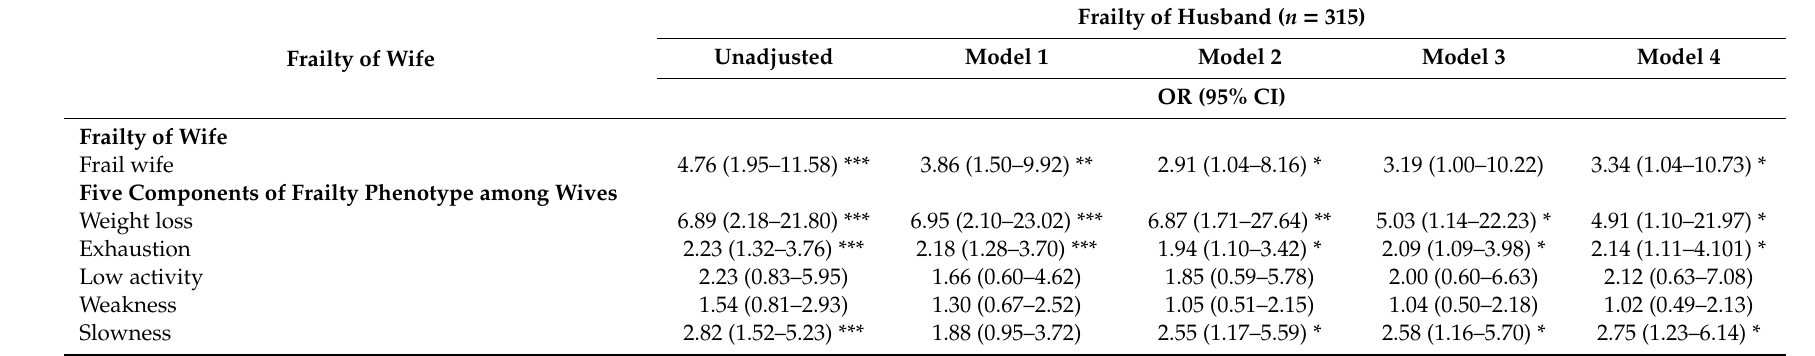
Table 3. Husband’s odds of frailty when the wife is frail in 315 married couples.